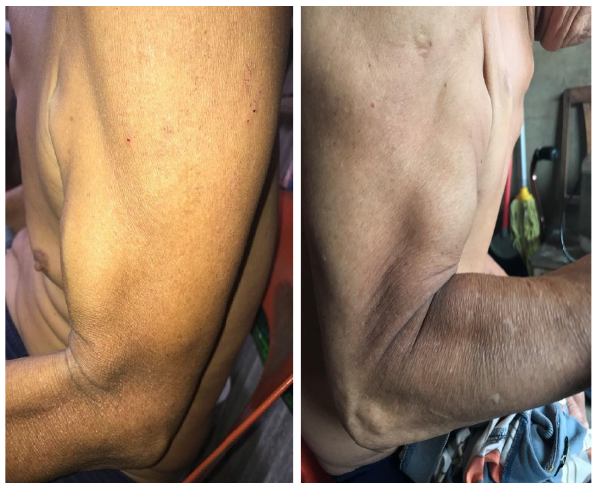
Figure 2 . Left and Right Popeye